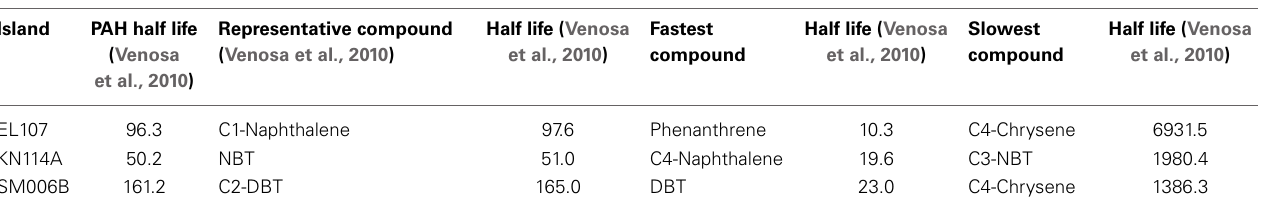
Table 6 | Comparison of biodegradation rates for natural attenuation experiments. Island